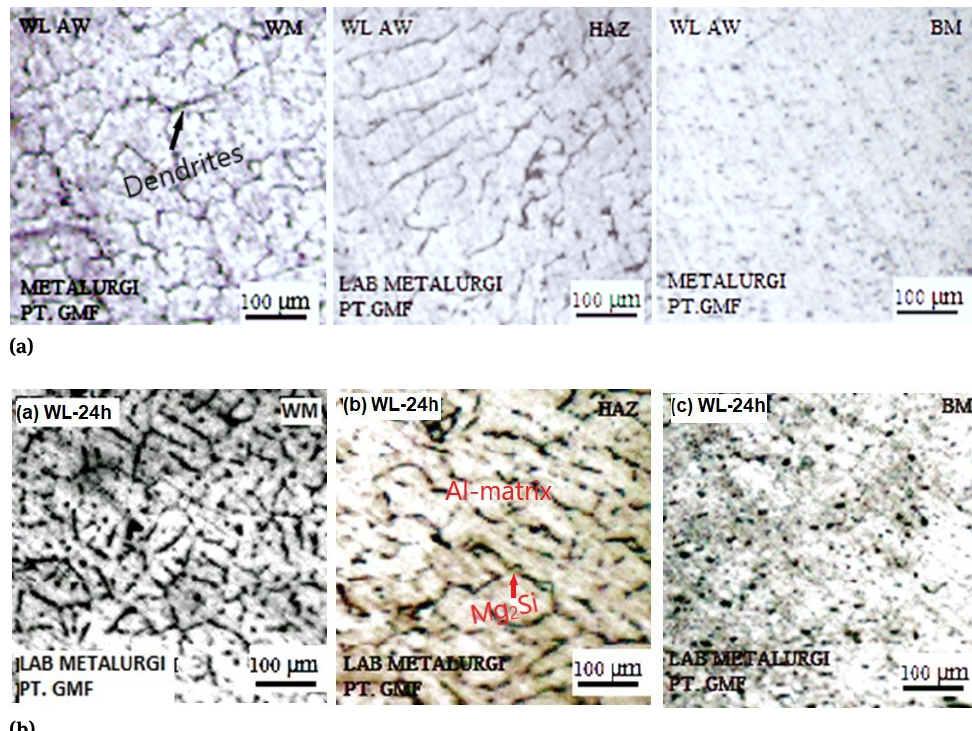
Figure 5: OM images as a comparison of; (a) As-welded AL6061, and (b) AL6061-T6 aged for 24 hours on longitudinal welding orientation for WM, HAZ, and BM (left to right).